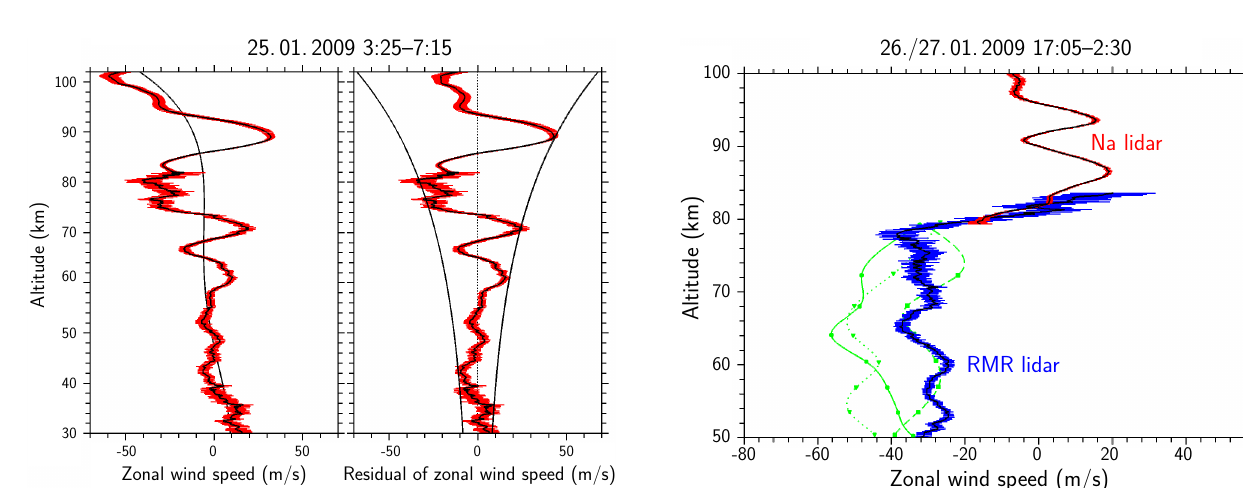
Fig. 9. Nightly mean vertical profiles of zonal wind speed on 26/27 January measured by RMR lidar (blue error bars) and Na li- dar (red error bars) with the NWT. Integration time is roughly 10h. Green lines show zonal wind speed from ECMWF data (dashed: 18:00UT, solid: midnight, dotted: 06:00UT; dots mark the model levels). Note that, in the height range of overlap (79–83km), winds derived by both lidars are shown and match very well (except for the top altitudes